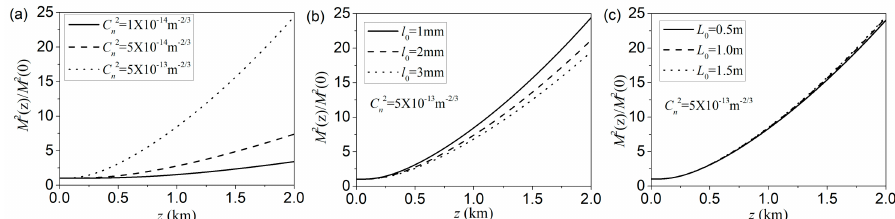
Figure 8. Variation of the normalized propagation factor with the propagation distance for different ( a ) structure constants, ( b ) inner scale sizes and ( c ) outer scale sizes. The initial coherence width of the MCLGC beam in the calculation is δ 0 = 4